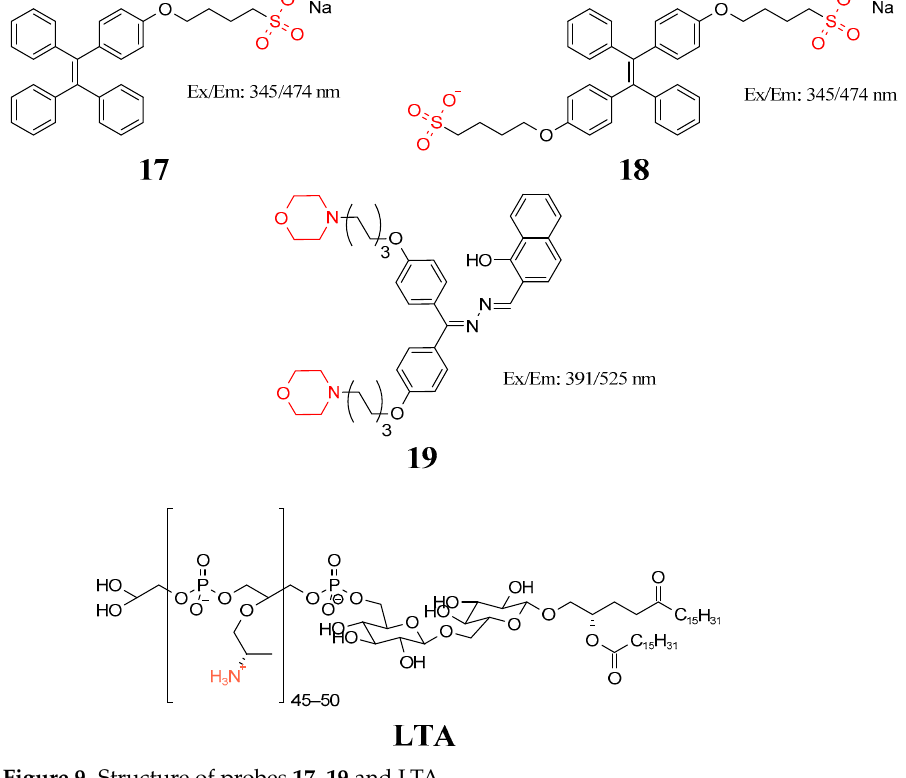
Figure 9. Structure of probes 17 – 19 and